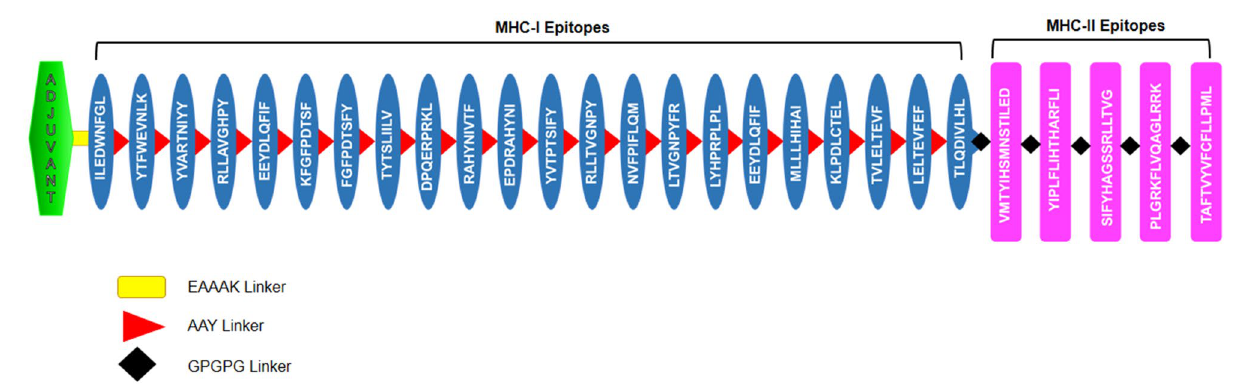
Figure 2. Schematic representation of the prepared multi-epitope chimeric vaccine construct having adjuvant, MHC-I & MCH-II epitopes linked with EAAAK, AAY & GPGPG linkers